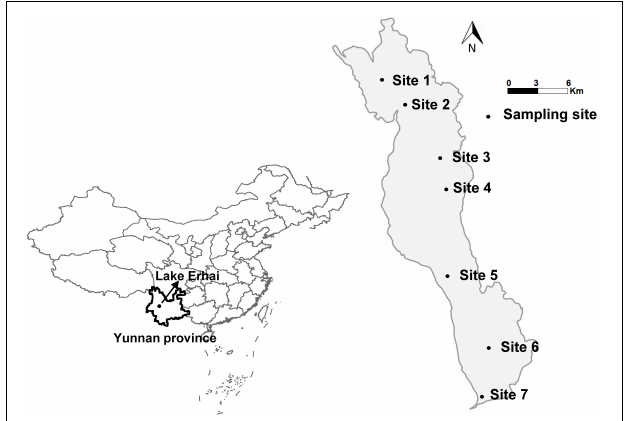
FIGURE 1 | A map of Lake Erhai with the location of the sampling